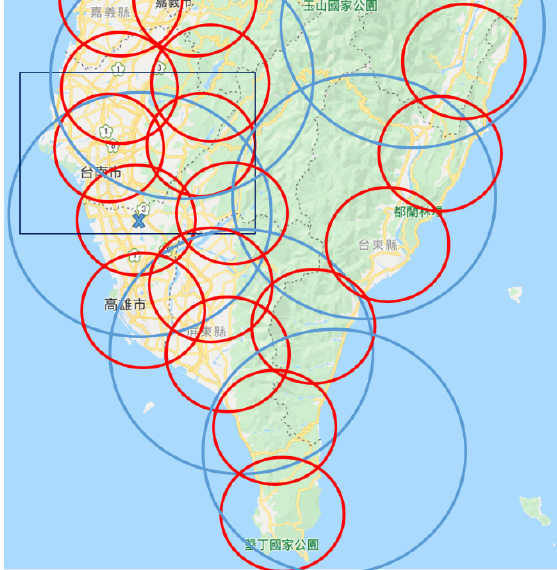
Figure 2. Automatic dependent surveillance-broadcast (ADS-B) like ground transceiver station (GTS) deployment in Southern Taiwan (red small circle for long-range wide area network (LoRa), blue large circle for automatic packet reporting system (APRS), CJCU at X , where rectangle enclosing Tainan City).